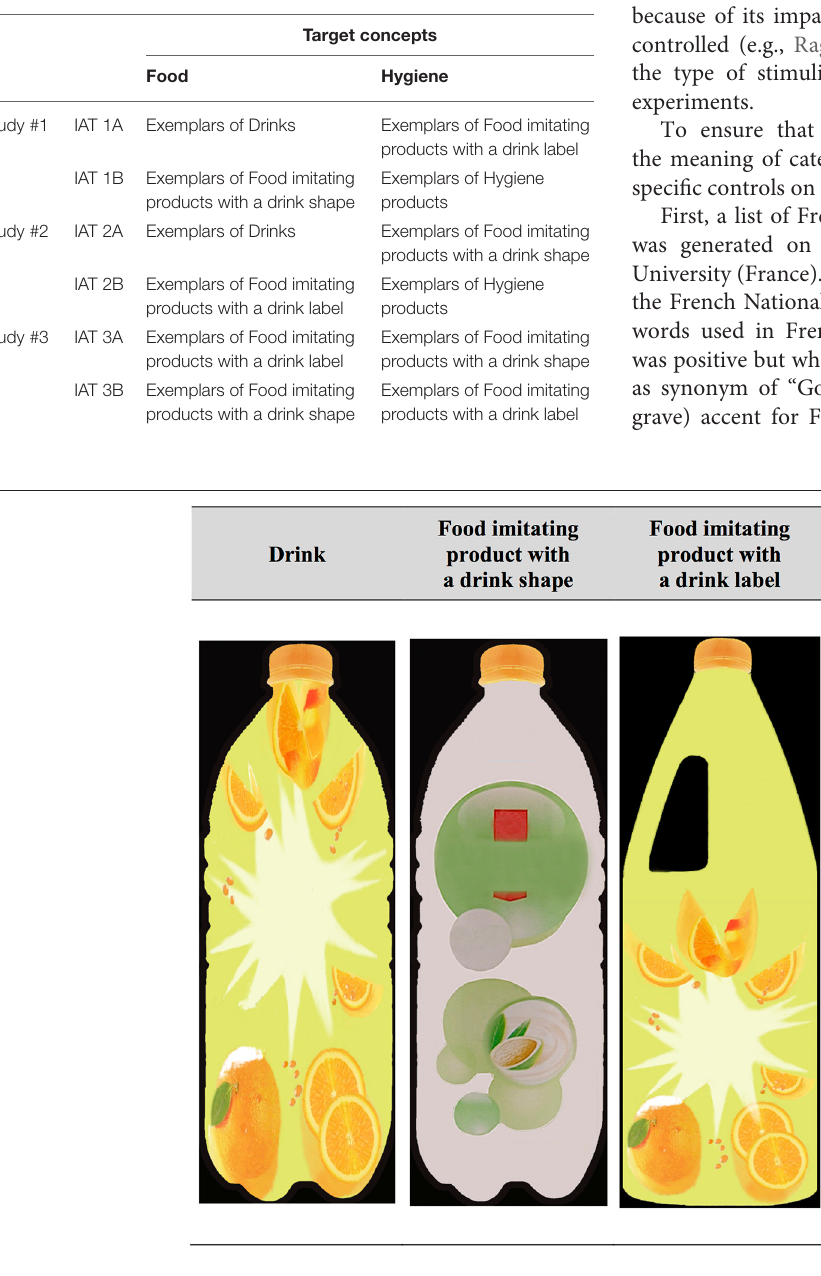
FIGURE 1 | Examples of target exemplars used in the experiment. These are not actual items from the experiment due to copyright issues.